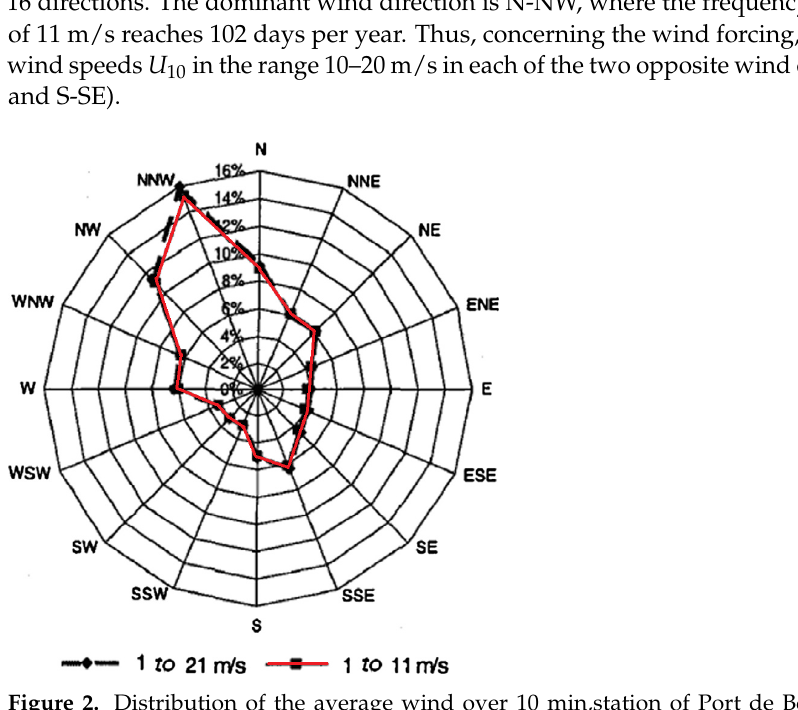
Figure 2. Distribution of the average wind over 10 min,station of Port de Bouc—10 m, period 1992–2001, 24,793 observations